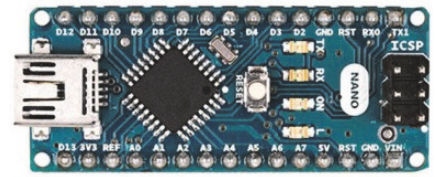
Figure 2: An Arduino nano development